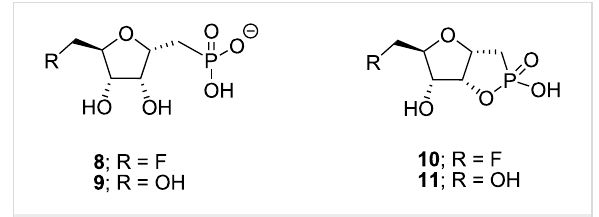
Figure 1: Synthesized phosphonates 8 and 9 and cyclic phostones 10 and 11